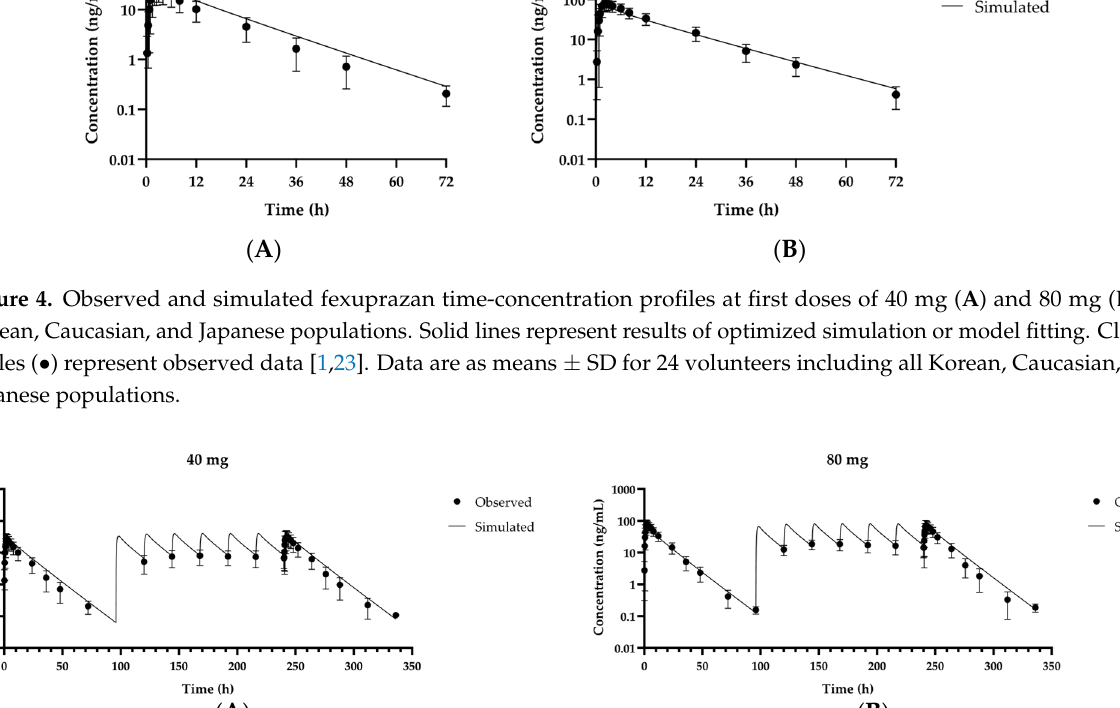
Figure 5. Observed and predicted fexuprazan concentration profiles at repeated doses of 40 mg/day ( A ) and 80 mg/day ( B ) on days 1, 5, 6, 7, 8, 9, 10, and 11 in Korean, Caucasian, and Japanese populations. Solid lines represent simulated results of optimized model or model prediction. Closed circles ( ● ) represent observed data [1,23] . Data are means ± SD for 24 volunteers including all Korean, Caucasian, and Japanese populations.